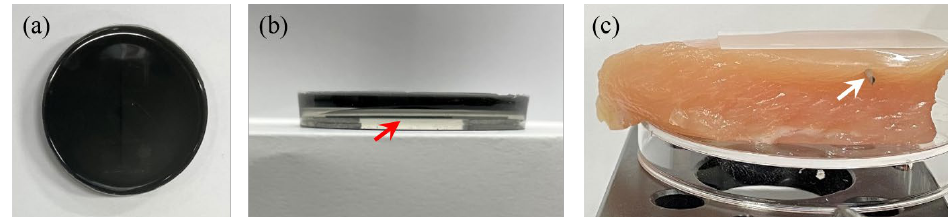
Figure 7. The specimens used for experiments. ( a ) Top view of a tissue-mimicking PDMS phantom and ( b ) its side view. A pencil lead with a 0.7 mm diameter, marked with the red arrow, was positioned at around 3.5 mm depth. ( c ) Chicken breast sample. A 1 mm diameter needle, marked with the white arrow, was positioned around 3.1 mm depth.